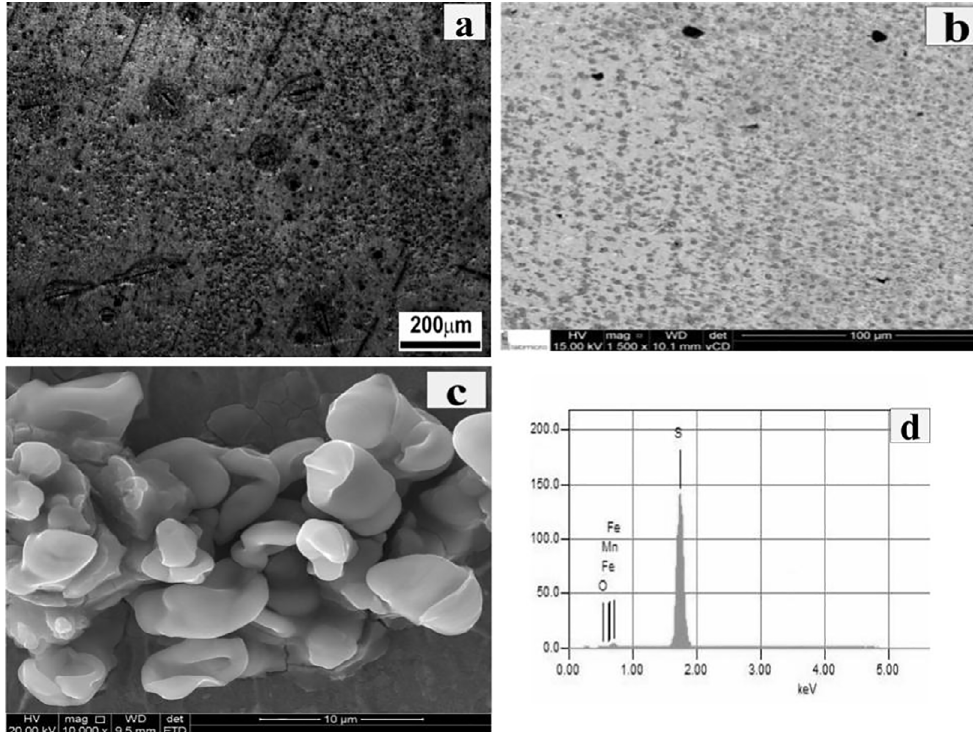
Figure 12. OM (a) and SEM (b) images of the API 5L X65 steel after 24h immersion in deaerated solution A, NACE TM0284 (2011), saturated with H